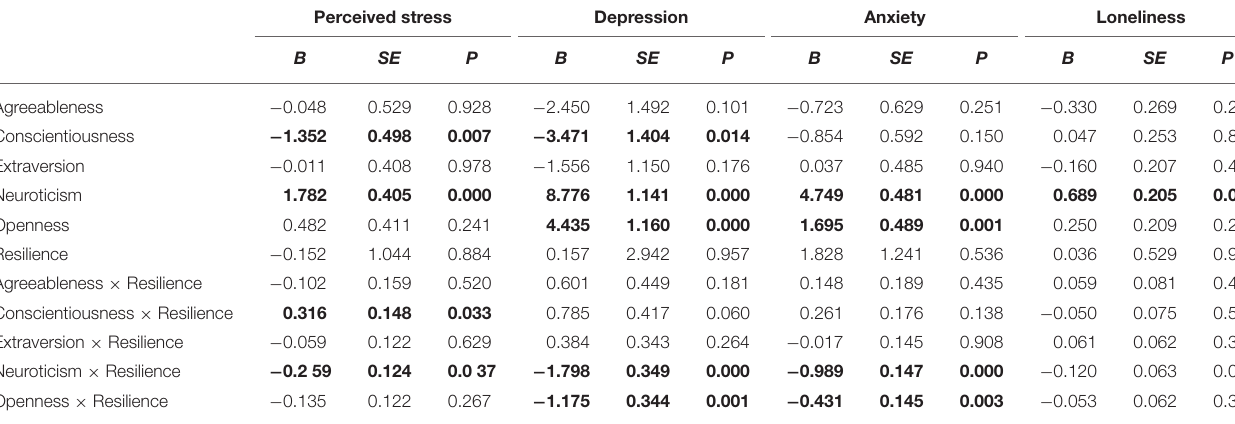
TABLE 5 | Associations of personality traits, resilience and mental health outcomes, controlling for sociodemographic variables. Perceived stress Depression Anxiety